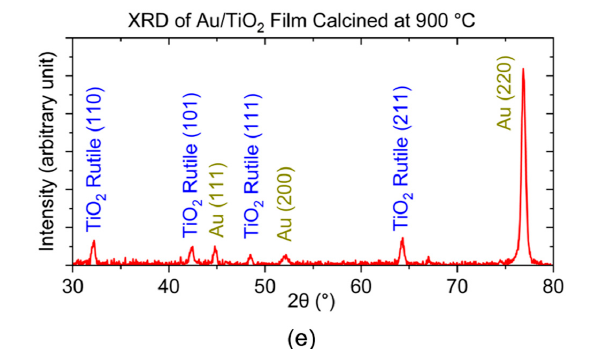
Figure 13. ( a ) Cross-sectional TEM image of post-temperature-sensing Au/TiO 2 film, with Au NP